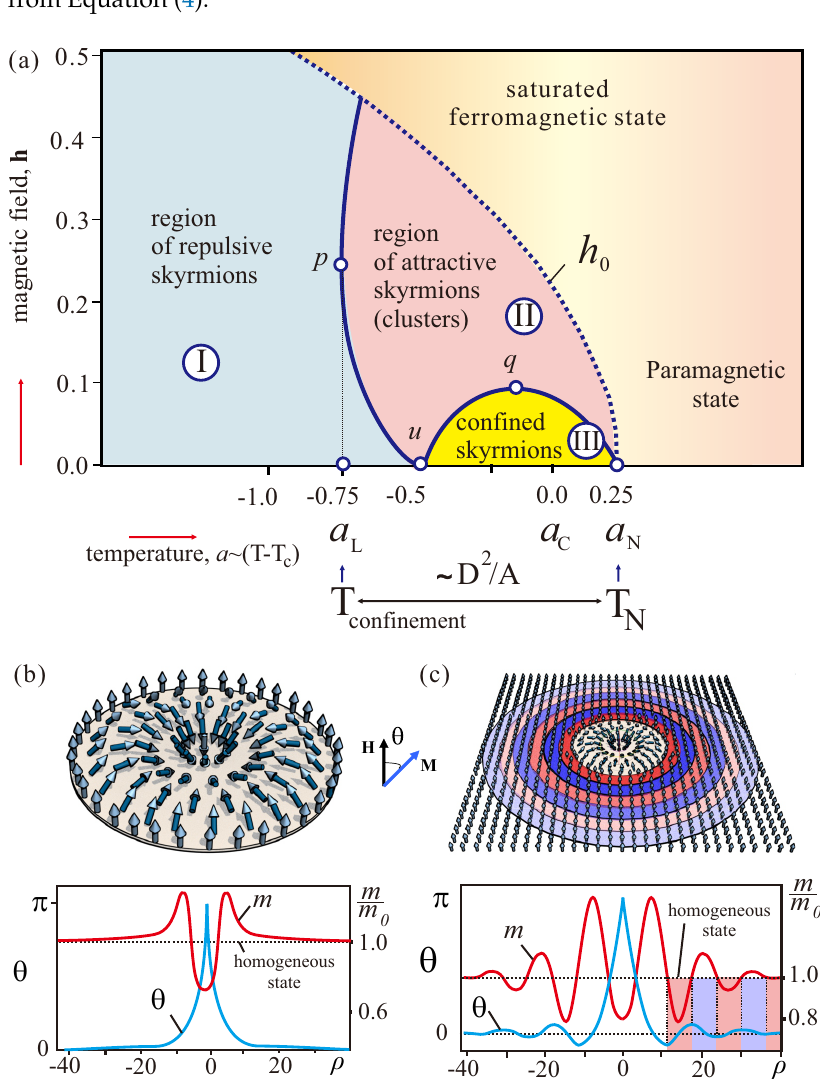
Figure 1. (color online) ( a ) The diagram on plane ( a , h ) showing the regions with different types of skyrmion–skyrmion interaction according to the analysis of IS asymptotic behaviour: I—repulsive interaction between isolated skyrmions; II—attractive inter-skyrmion interaction; III—the region of skyrmion confinement. Solid line is defined by Equation (20): the turning points have the following √ √ coordinates— p ( − 0.75, 2/4), q (0.06,0.032 5), and u ( − 0.5, 0). Above the dotted line h 0 no isolated skyrmions can exist, since they collapse. ( b ) Dependences of angular θ and longitudinal m order parameters on polar coordinate ρ for isolated skyrmion in region I ( a = − 1, h = 0.4). ( c ) θ ( ρ ) and m ( ρ ) for isolated skyrmion in region II ( a = 0.21, h = 0.05). Shaded parts of oscillating profiles emphasize “wrong” and “right” rotational senses according to DMI. The oscillations are damped and end at the level of the homogeneous